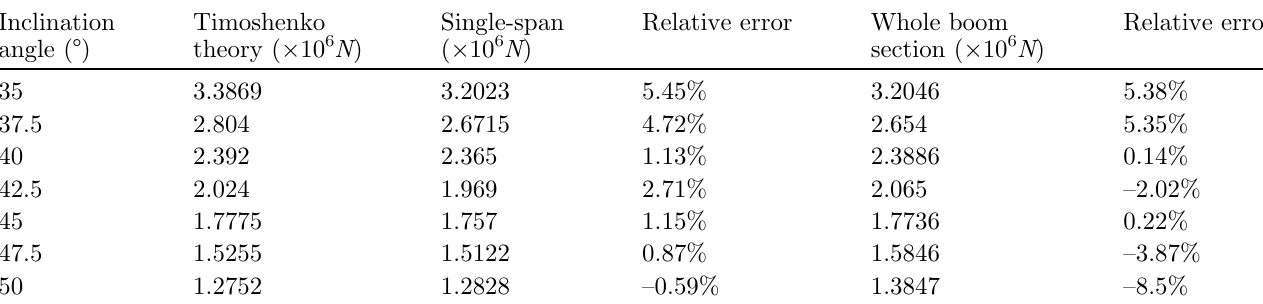
Table 4. Comparison of critical load calculation for changing the web member inclination